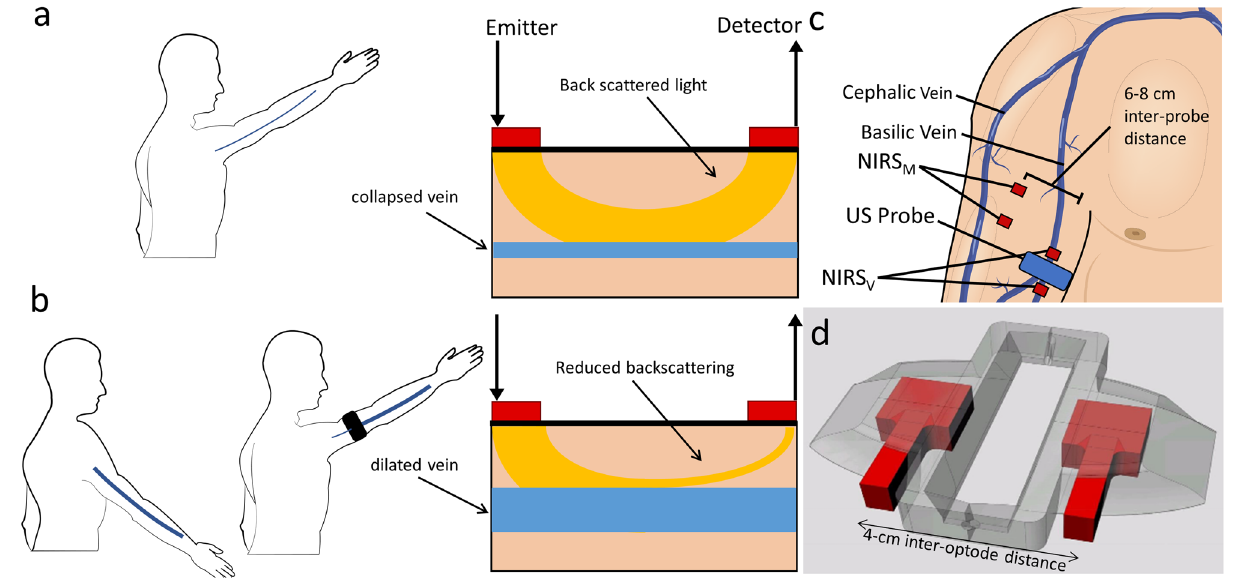
Figure 1. ( a ) Vein collapse during arm elevation results in little absorption of NIR light by the vein and consequently in high intensity of the light backscattered to the detector. ( b ) Vein dilation, during, e.g., arm lowering or venous occlusion, increases the absorption and reduces the amount of backscattered light, which produces an increase of NIRS blood volume indexes; ( c ) location of NIRS probes: one NIRS probe was positioned over the biceps muscle belly (NIRS M ) and one over the basilic vein (NIRS V ); an ultrasound probe was coupled with NIRS V to monitor size changes in the cross-sectional area of the basilic vein; ( d ) custom 3D-printed probe holder, designed to embed the linear US-probe (not drawn) in-between NIRS optodes (in red). The figure was created with Adobe Illustrator 2020, v. 24.1.1, www. adobe. com ( a,c ), MS PowerPoint 2019, v. 2111, www. micro soft. com ( b ), and Rhino 7 v.7.13, www. rhino 3d. com ( d